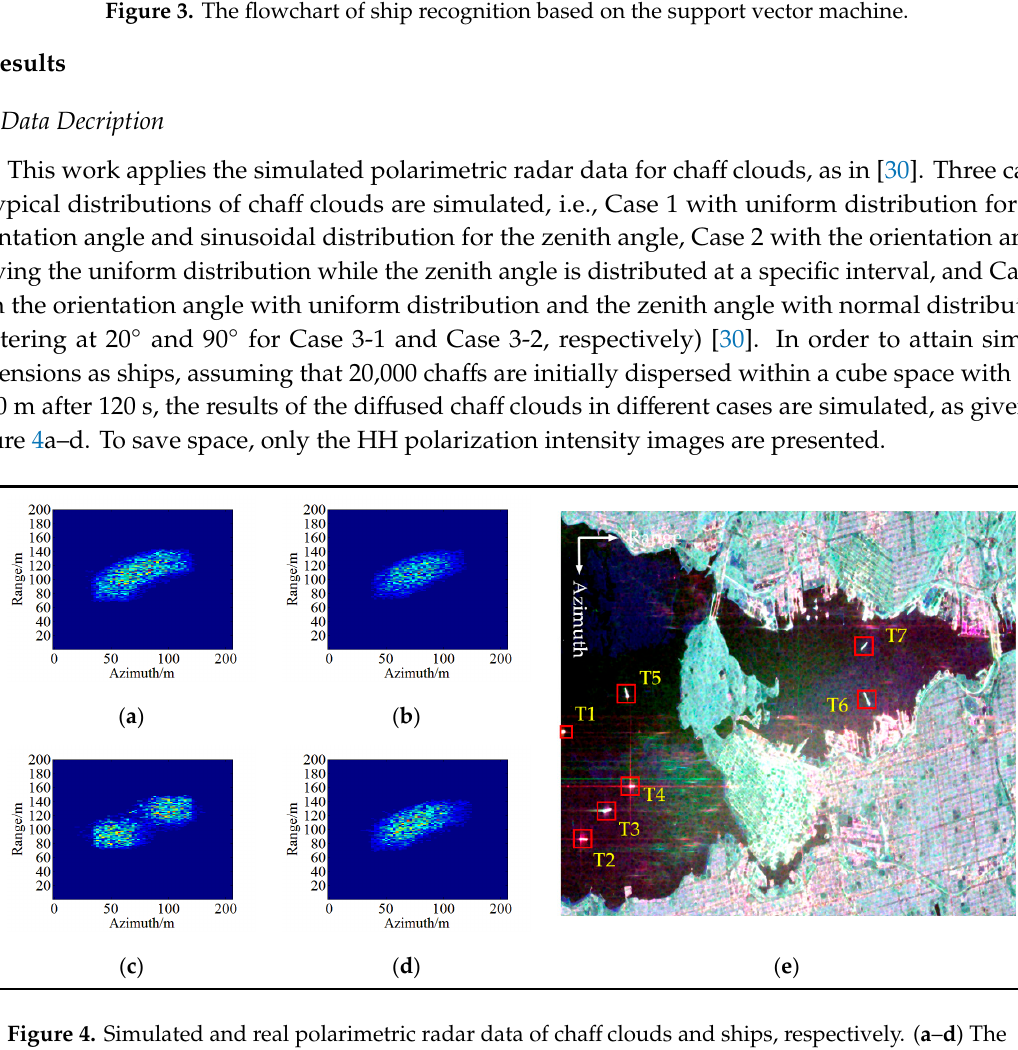
( d ) Figure 5. Decomposition results for chaff clouds in different cases. ( a ) Case 1. ( b ) Case 2. ( c ) Case 3-1. ( d ) Case 3-2. (red: double-bounce scattering, green: volume scattering, blue: surface scattering). Table 1. Scattering contribution statistics for chaff clouds. Chaff Clouds